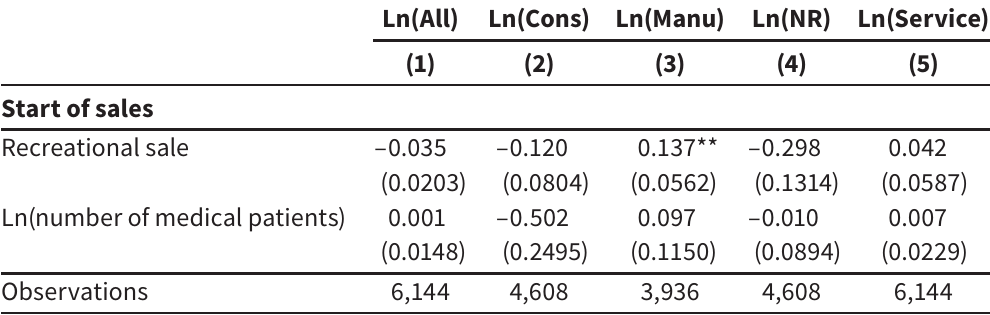
The effect of recreational dispensary entry on employment – ATT from